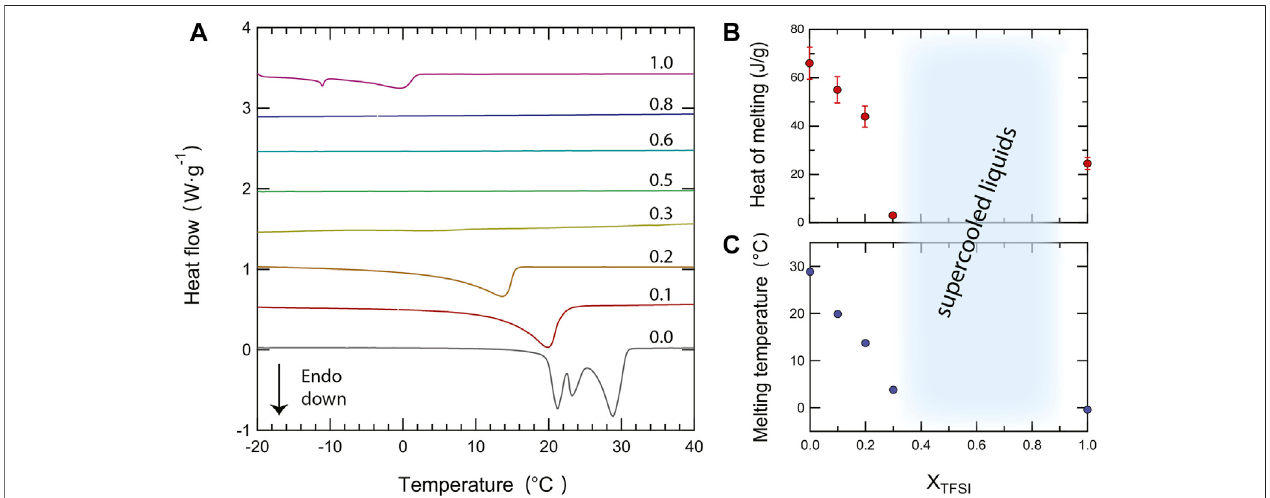
FIGURE 3 | Close-up of the differential scanning calorimetry (DSC) curves in the temperature range of the melting transition ( − 20 — 40 ° C) recorded during the secondheatingscanforallproticionicliquidmixtures (A)